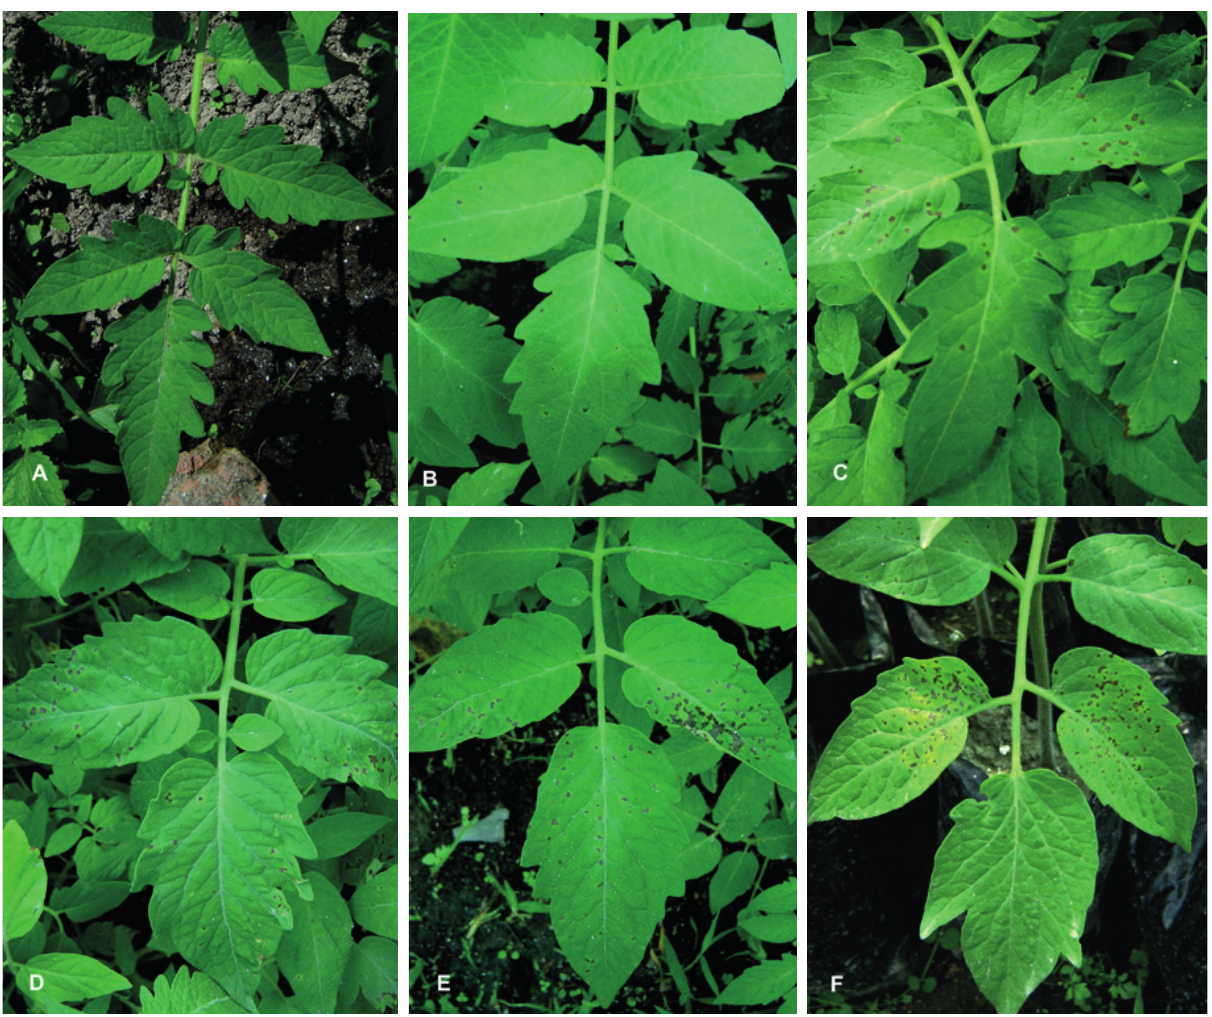
Figure 1. Determination of the Disease Severity Index based on the number of lesions on tomato leaves, using a scale from 0 to 5. A, no lesion. B, 1–15 lesions. C, 16–30 lesions. D, 31–60 lesions. E, 61–120 lesions. F, more than 120 le-